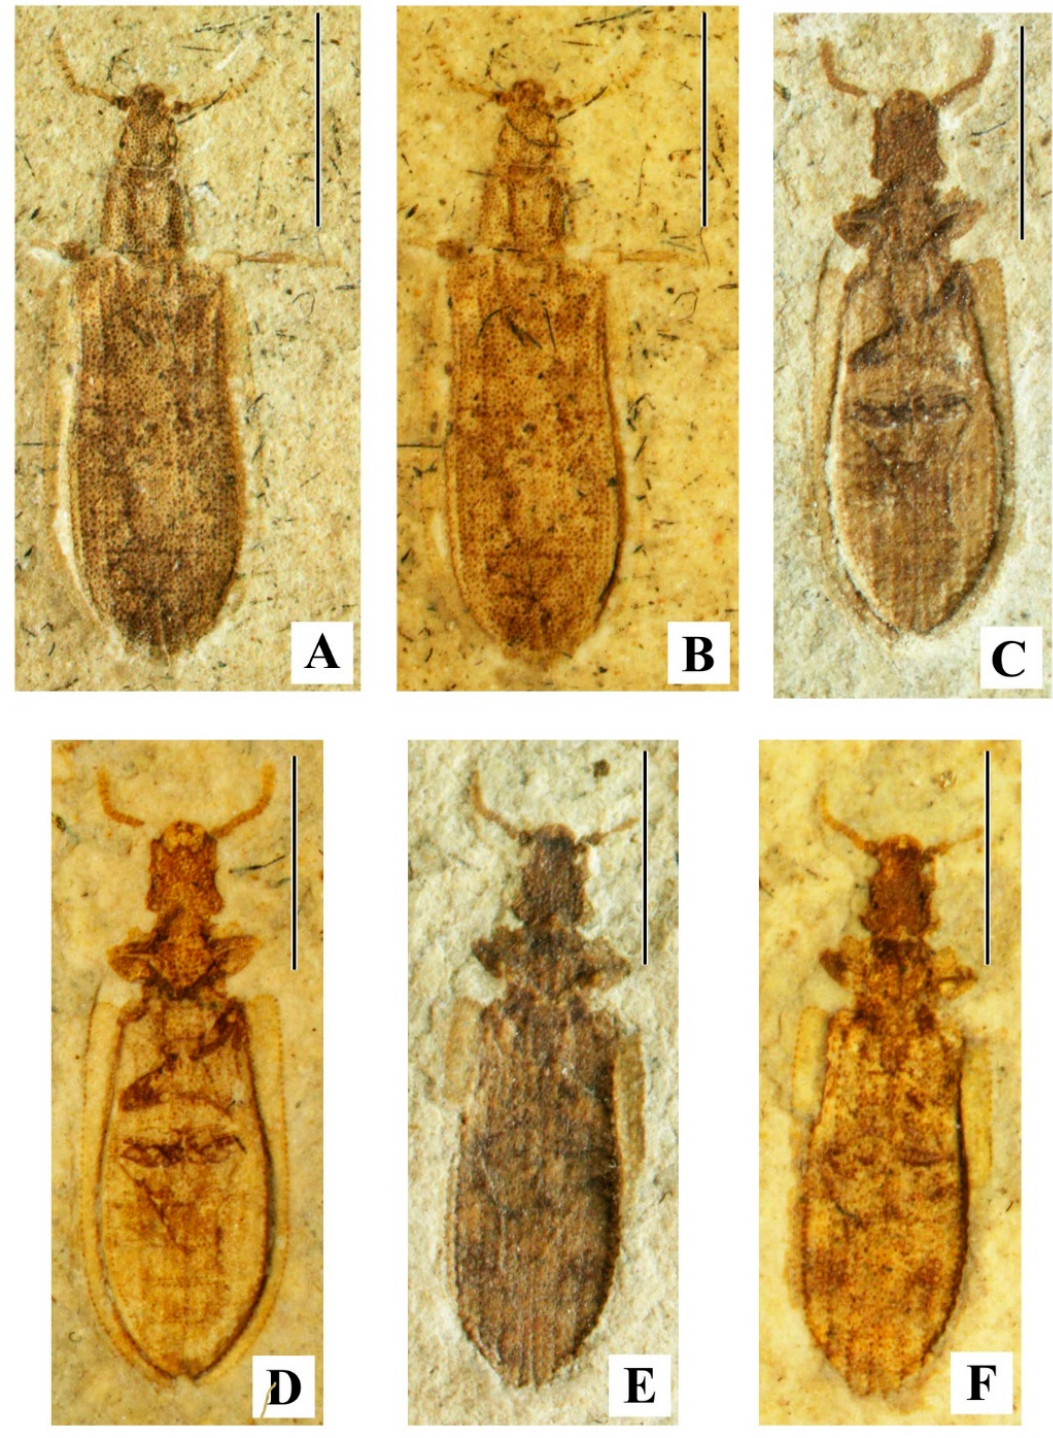
Figure 15. Ommatinae (Cupedidae): A – B —(?) Pareuryomma angustum comb. nov. [ Brochocoleus ], holotype CNU—C-LB2006009 (Lower Cretaceous, Lower Aptian; Liaoning, Chaomidian): A —dry and B —wettened by alcohol; length of print 14.0 mm, scale bar = 5.3 mm; original. C-F— Pareuryomma tylodes , holotype, CNU—C-LB2005003-1, part and CNU—C-LB2005003-2, counterpart (Lower Cretaceous, Lower Aptian Liaoning, Chaomidian); C —part, dry, D —same, wettened by alcohol; E —counterpart, dry, F —same, wettened by alcohol; length of print 6.3 mm, scale bar = 2.5 mm; original.